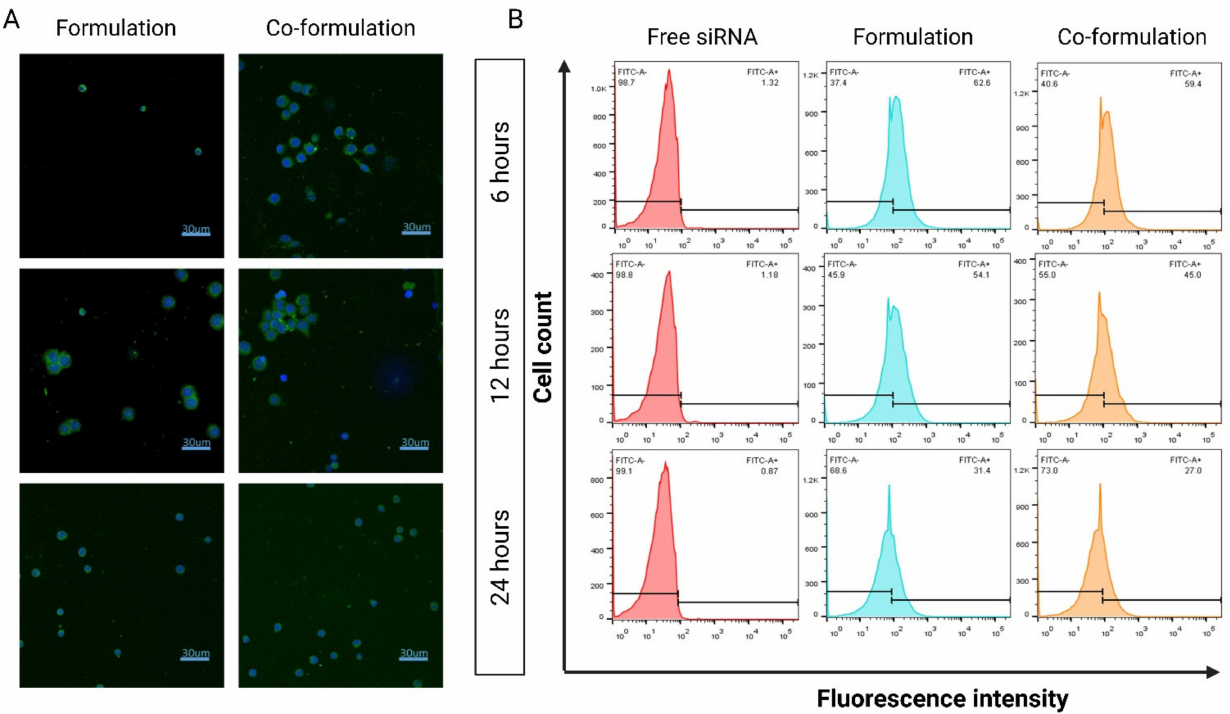
Figure 5. Cellular Uptake. ( A ) Confocal images of uptake into HL-60 cells with NPs incorporating FAM-labelled siRNA (green). Magnification 40 × . ( B ) Flow cytometric analysis of HL-60 cells treated with different CD-based NP formulations at 6, 12 and 24 h. Formulation MR 8.5:1 (cationic